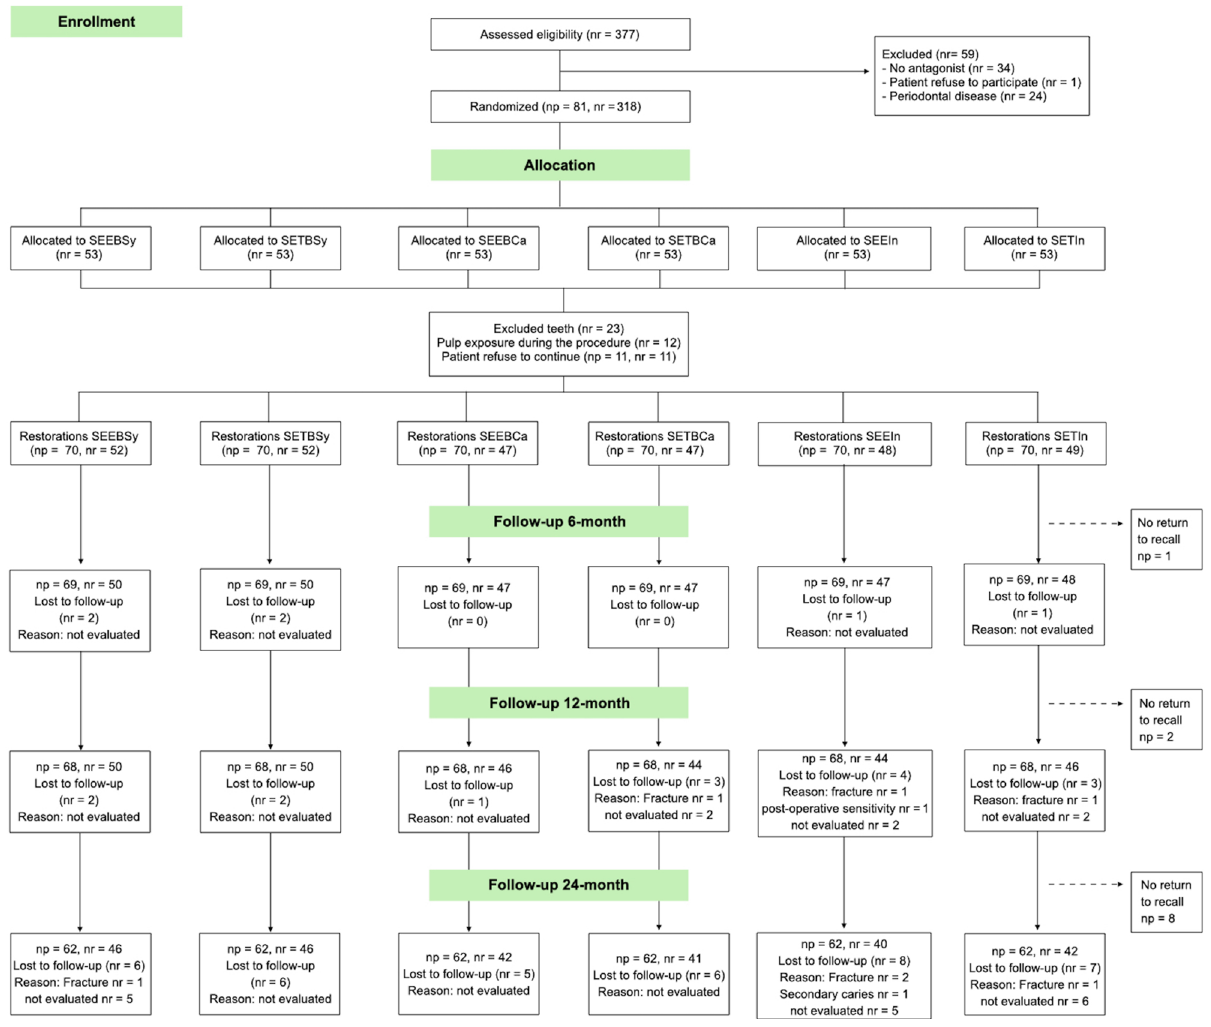
Figure 1- Participant flow diagram in the different phases of the study design. Abbreviations: np – number of participants; nr – number of restorations; (*) SEEBSy, self-etch with selective enamel etching and bulk in syringe; SETBSy, self-etch and bulk in syringe; SEEBCa, self-etch with selective enamel etching and bulk in capsule; SETBCa, self-etch and bulk in capsule; SEEIn, self-etch with selective enamel etching and incremental composite; SETIn, self-etch and incremental